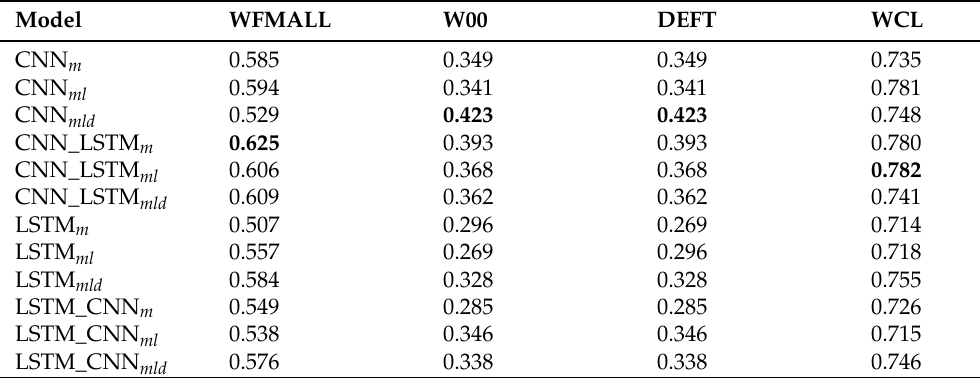
Table 8. Information gain rankings for individual models within the ensemble model.